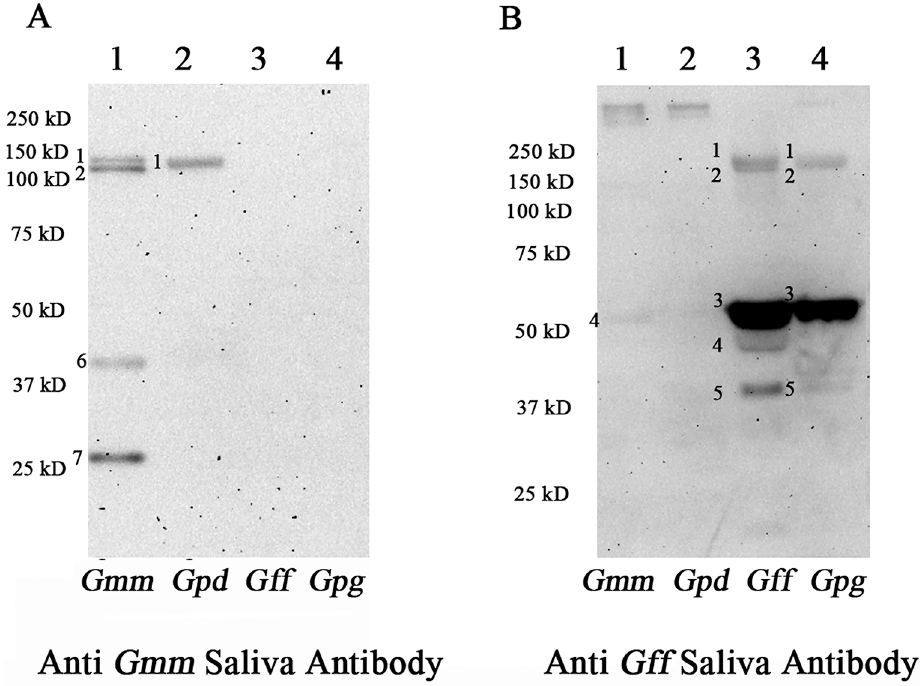
Fig 2. Immunogenic potential of sialome components in different tsetse species. The same amount of sialome proteins from Gmm , Gpd , Gff and Gpg were analyzed by immunoblot analysis using sera obtained from mice exposed to (A) Gmm and (B) Gff bites. Bands detected are numbered corresponding to Fig 1.